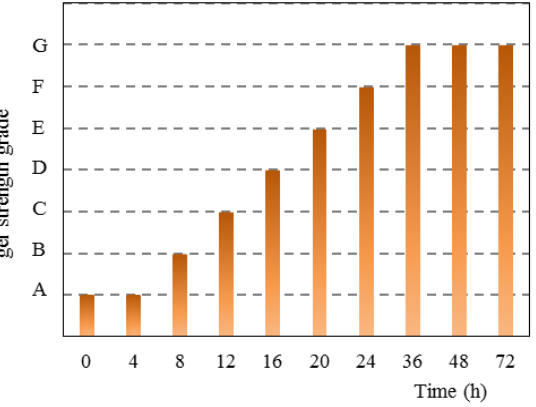
Figure 4. The relationship between gel strength and time of polymer gel.